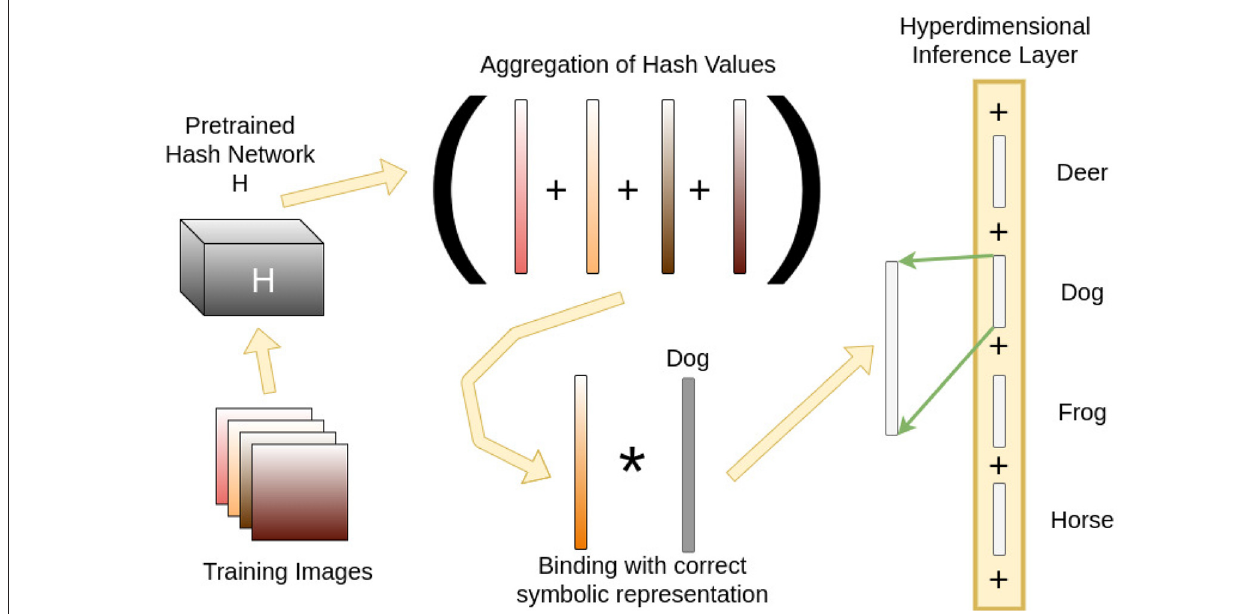
FIGURE 3 | The training pipeline for a particular class of “dog.” First, training images are hashed into binary vectors using a pre-trained network. The vectors for each image are then projected to a hyperdimensional length by randomly repeating the bits consistently. Each vector is aggregated by the consensus sum operation into a single vector containing all training instances for that class. A symbolic representation of the class, called “Dog” in this example, as another hyperdimensional vector, is bound to the aggregated vector. This forms the association between representative images and the class itself. Once these inference vectors are computed for each class, they are aggregated by consensus sum into the Hyperdimensional Inference Layer, which then performs classification at testing